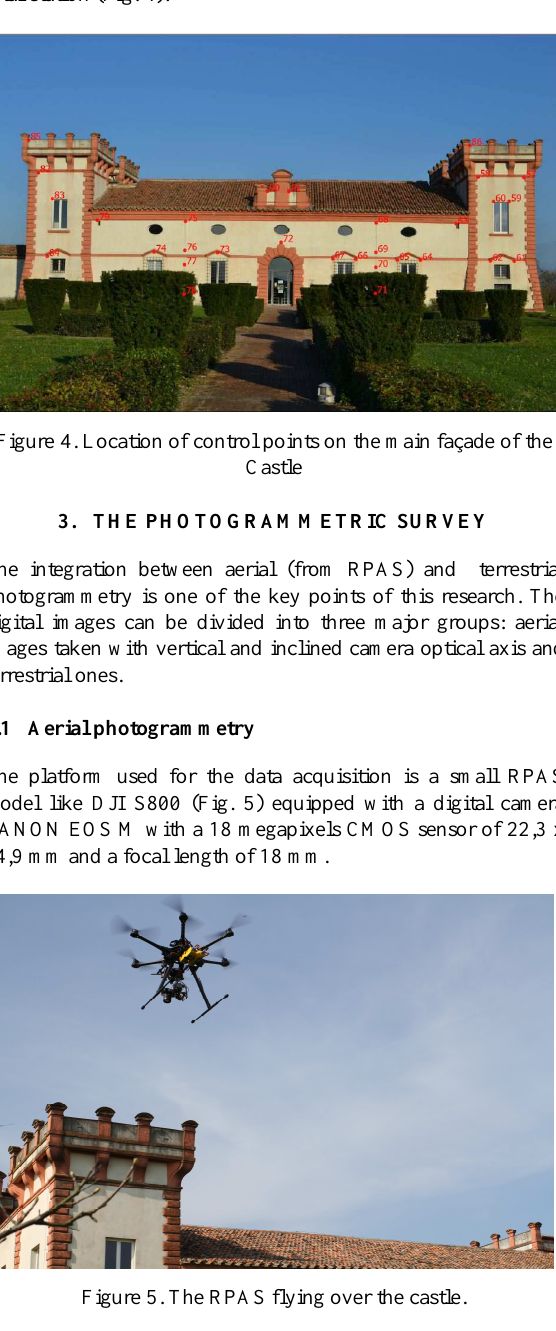
Figure 3. The TLS point cloud model of the Castle Moreover 96 horizontal and vertical control points divided equally between the four sides of the castle were surveyed by total station (Fig. 4).